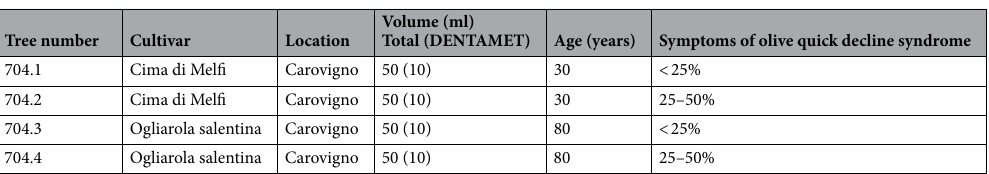
Table 3. List of the experimental trials conditions for the studied trees. Symptoms incidence was visually assessed 9 and PCR analyses 7 .